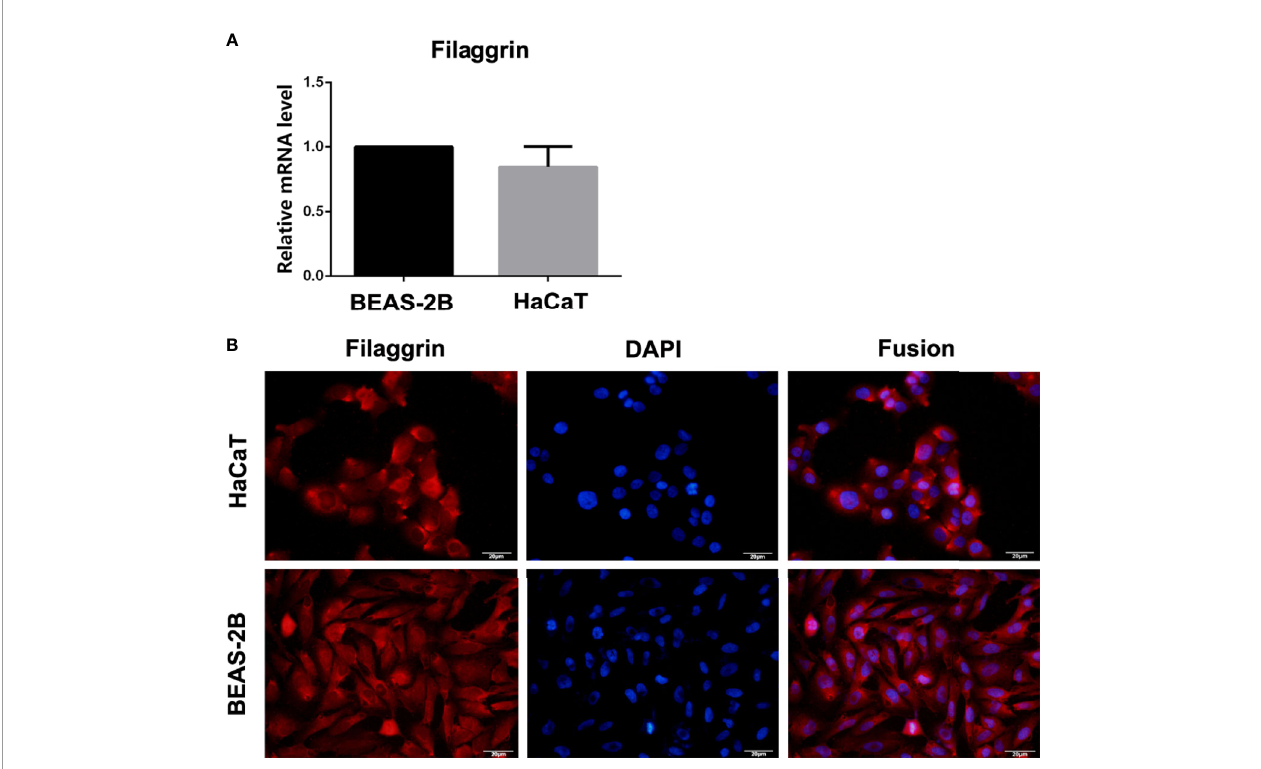
FIGURE 1 | The mRNA and protein expression of fi laggrin in BEAS-2B and HaCaT cells. (A) Filaggrin mRNA expression in HaCaT cells and BEAS-2B cells. (B) Immuno fl uorescence (IF) results of fi laggrin in BEAS-2B and HaCaT cells. The photographs were magni fi ed of 400 times and the bars represented 20 m